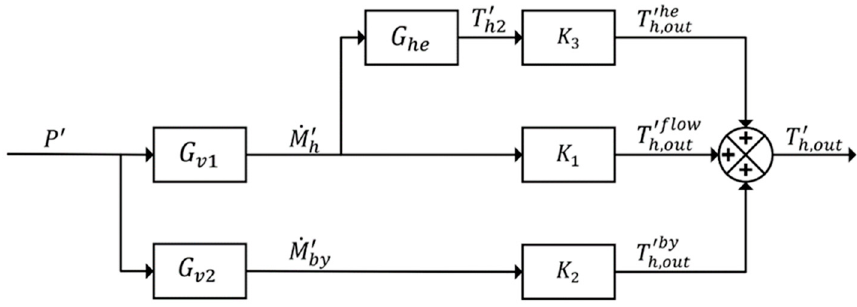
Figure 4. Block-diagram representation of the bypass configuration for the heat exchanger.